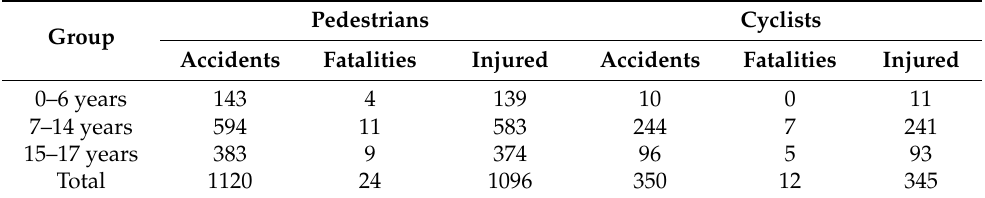
Table 1. Road accidents with children as pedestrians and cyclists in 2019 in Poland.